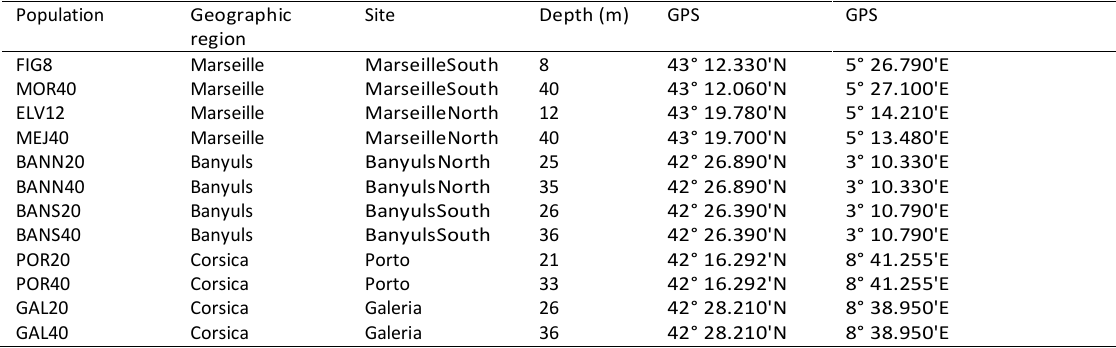
Table 1. Characteristics of red coral sampling